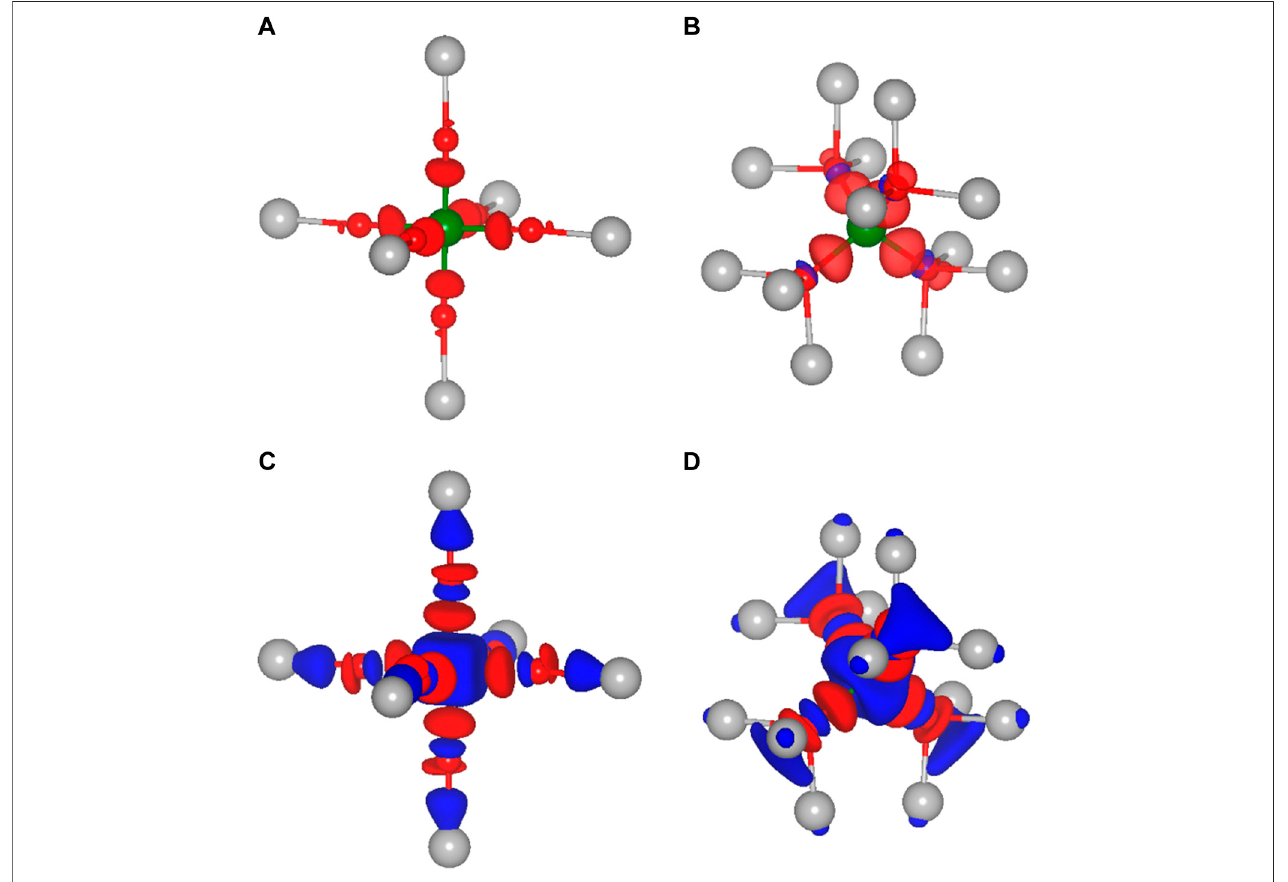
FIGURE3| Isosurfaces ofthechargedensity differenceofMgSc 2 Se 4 structuresinsideviewwiththechargecarrier (A) Li, (C) Alinoctahedralcoordination and (B) Li, (D) Al in tetrahedral coordination. Areas of charge depletion are shown in blue and areas of charge accumulation are shown in red.